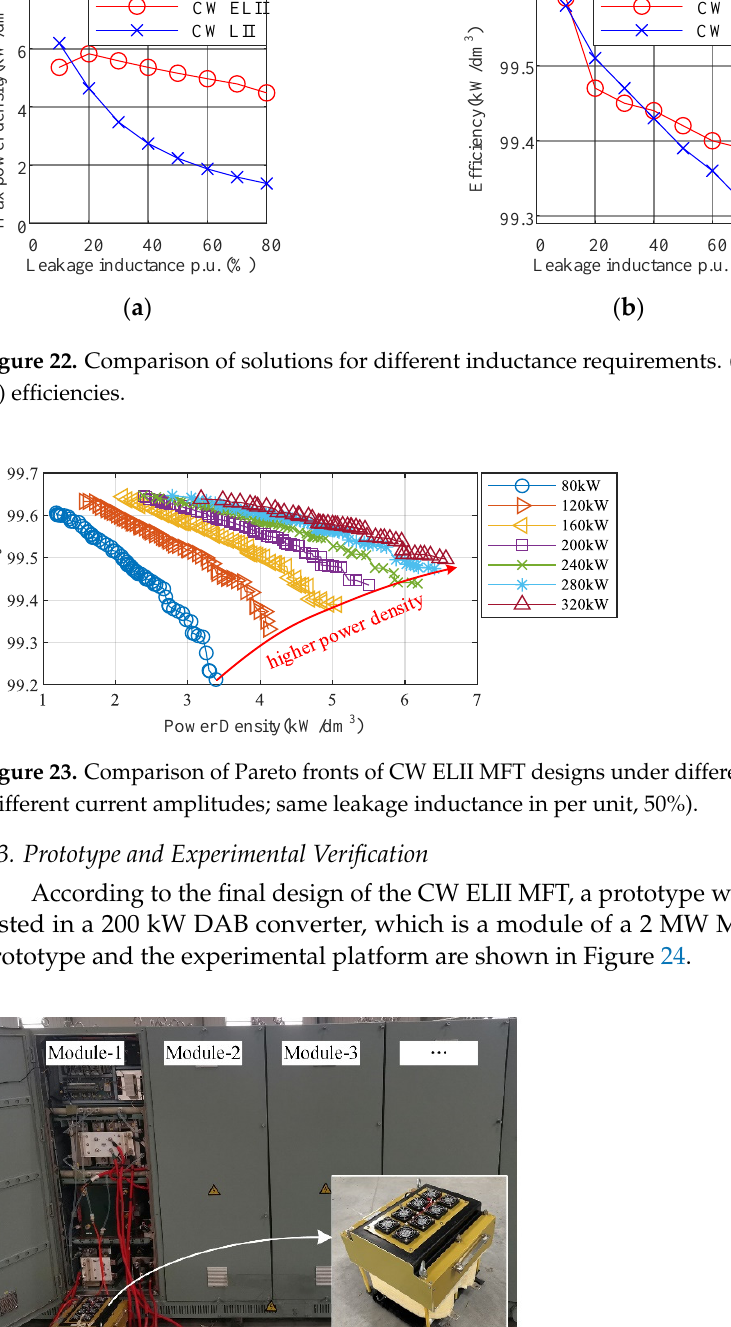
Figure 25. Voltage and current waveforms of the no-load condition. Figure 26 shows the voltage and current waveforms under the load condition with an output power of 200 kW, in which the DC voltages is 1.6 kV/1 kV and the phase-shifting duty is 0.0875. The temperature rise experiment was carried out under this condition, where the inlet water temperature was 35.5 °C, the ambient temperature was 39 °C, and the average inlet wind speed was 1.0 m/s (measured by KIMO VT110). Figure 27 shows the MFT surface temperature distribution in thermal steady state. Contact sensors were placed on the core surface to monitor the core temperature. At the same time, to avoid the